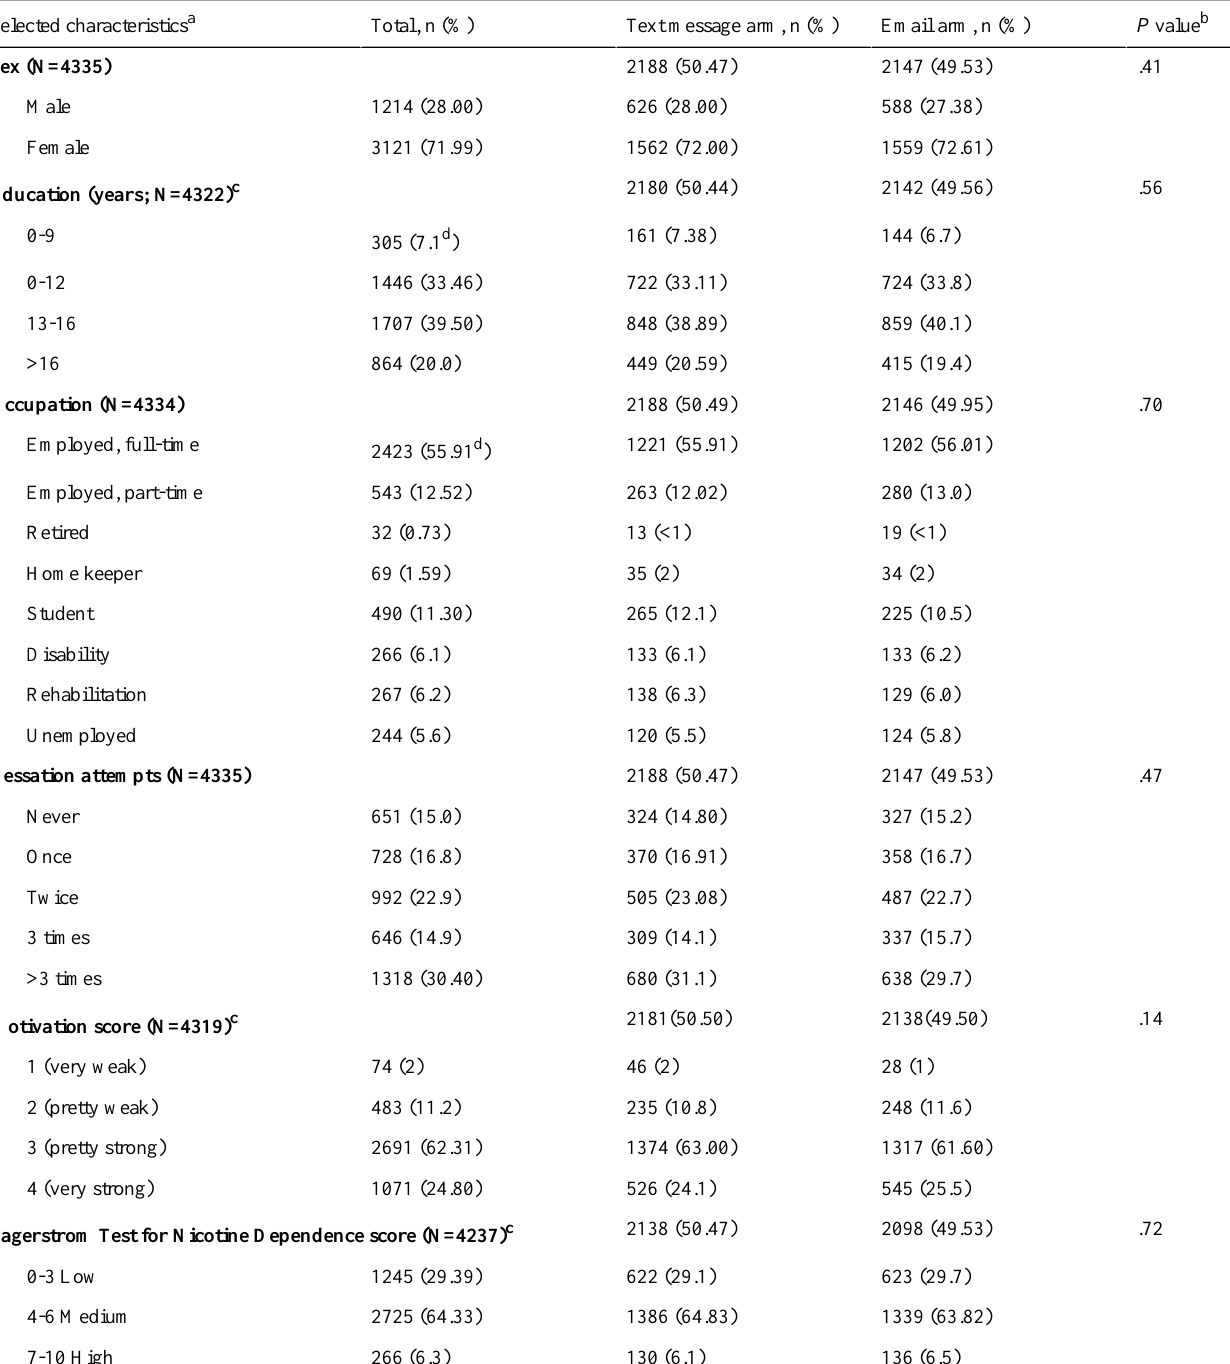
Table 2. Distribution of selected characteristics at baseline (N=4335) by study